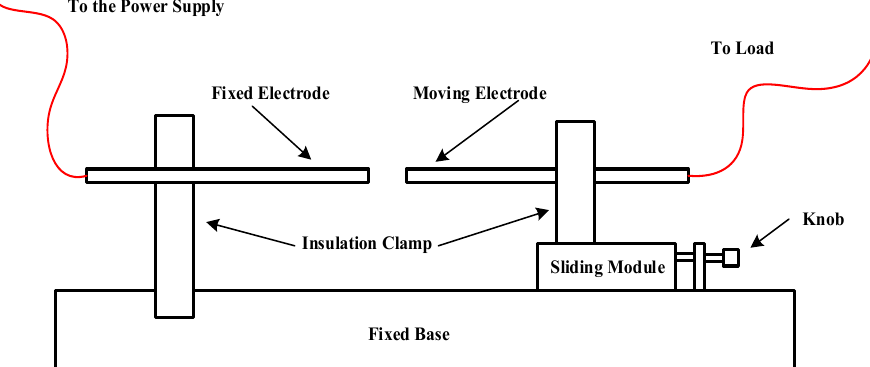
Figure 3. Diagram of the arc generator.